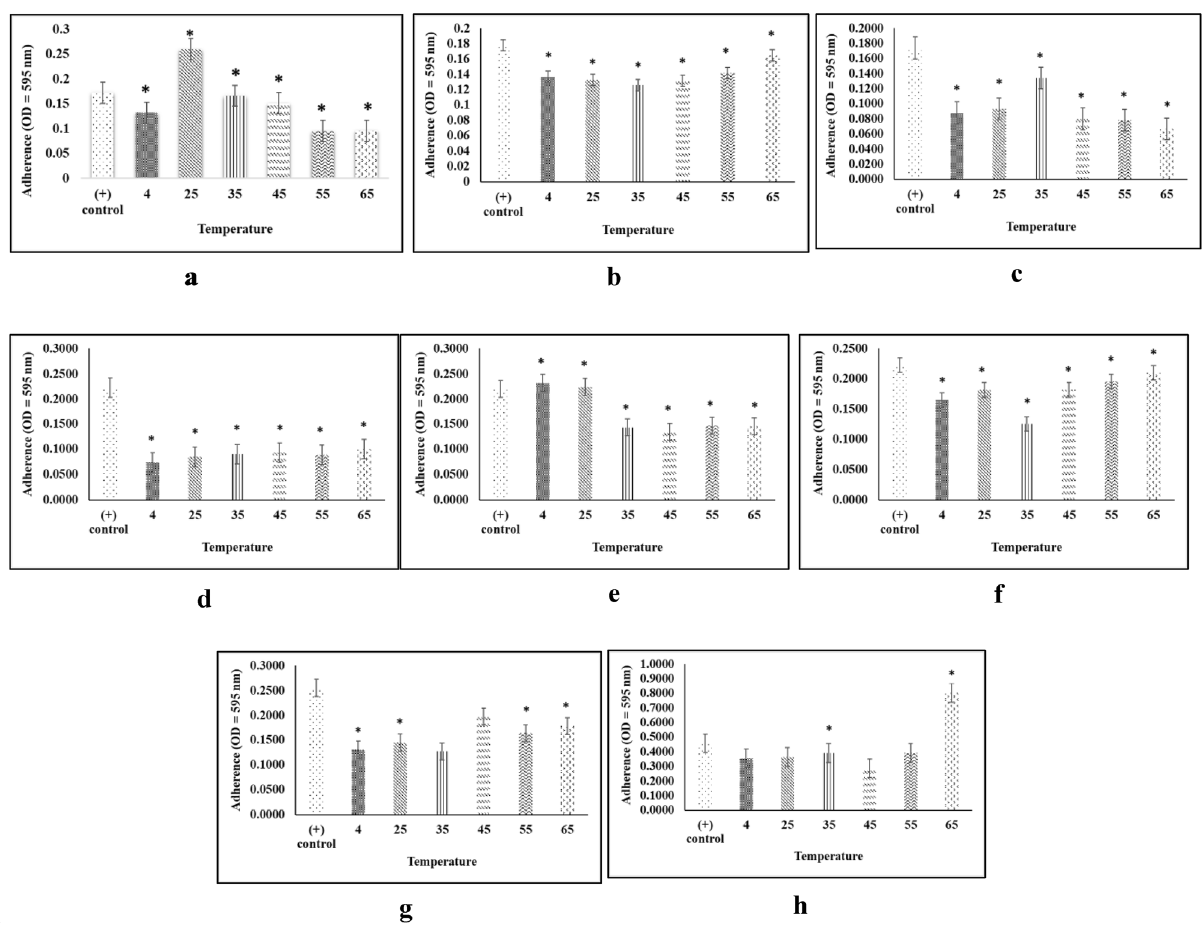
Figure 6. Stability of inhibition activity ( a ) 16PM, ( b ) 20PM, ( c ) 18PM, ( d ) 1AC and destruction activity ( e ) 16PM, ( f ) 20PM, ( g ) 18PM, and ( h ) 1AC (n = 6 replications; vertical bars are standard errors; *: significantly different at p <